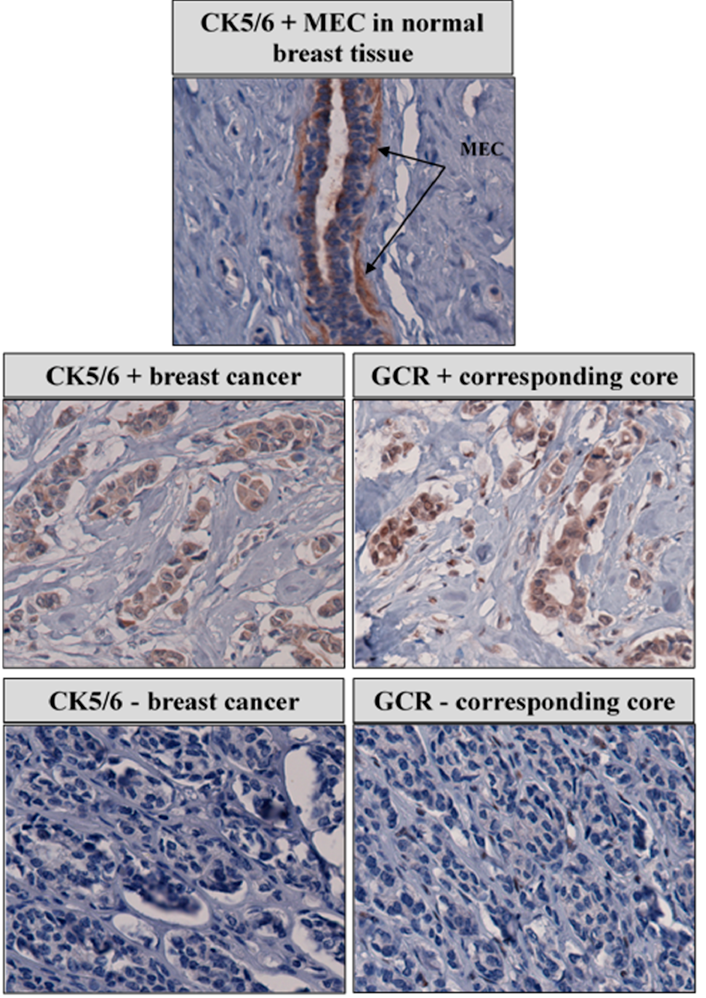
Figure 2. Correlation between GCR and CK 5/6 and expression in representative breast cancer cases.